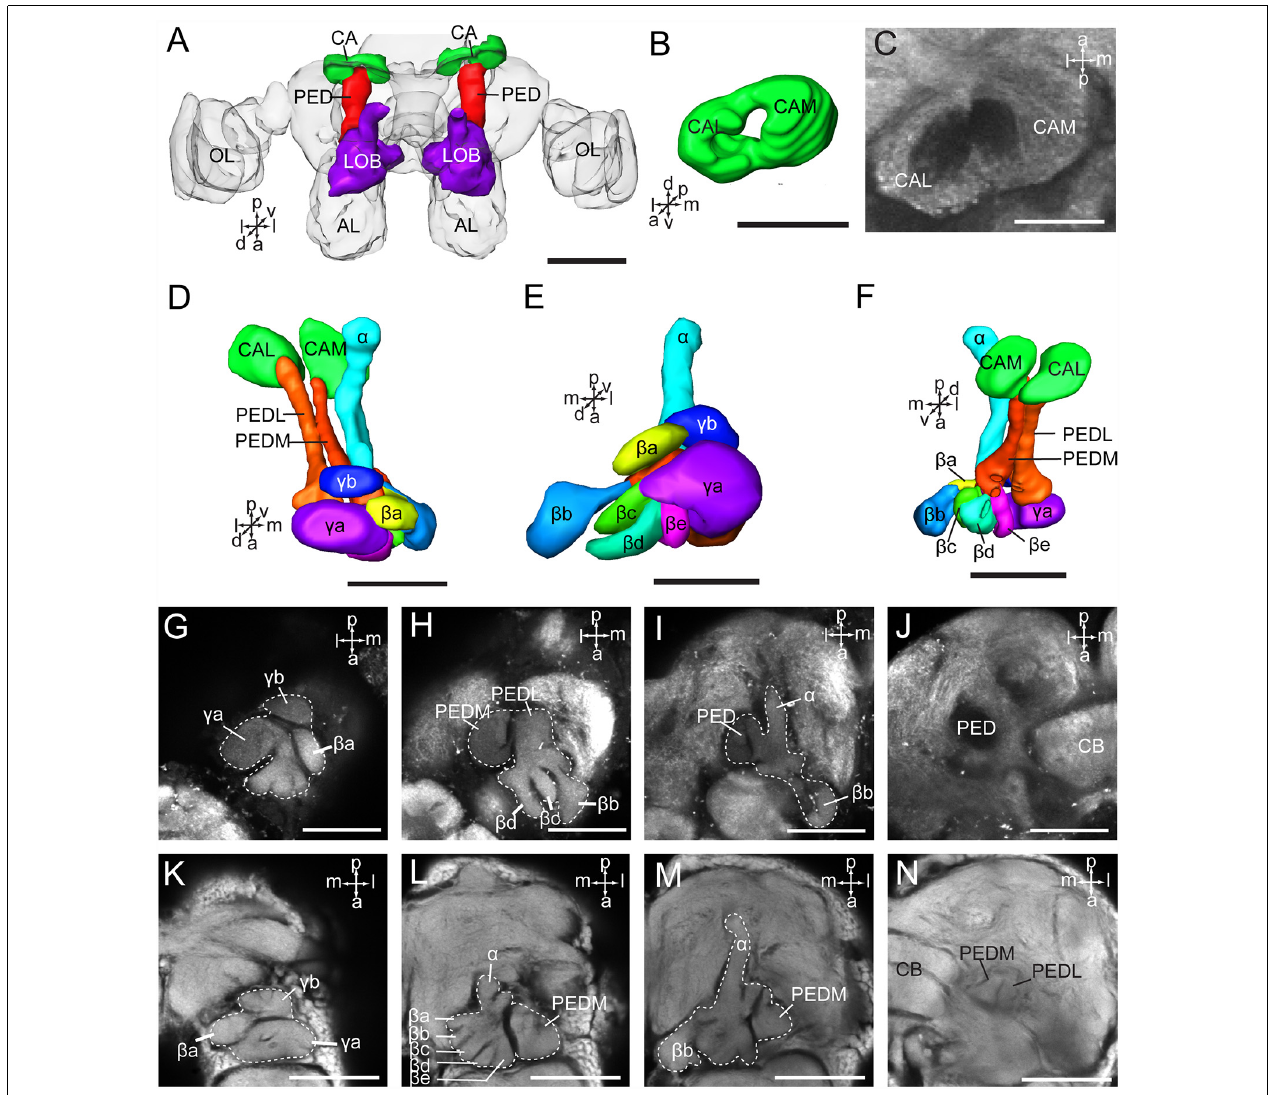
FIGURE 5 | Three-dimensional reconstructions and confocal images of Apolygus lucorum mushroom body. (A) Three-dimensional reconstructions of mushroom body in dorsal view. (B) Three-dimensional reconstruction of calyx in anterior view. (C) A confocal image showing the calyx. (D) Three-dimensional reconstructions of mushroom body in dorsal view. (E) Frontal view. (F) ventral view. (G–J) Confocal images at different depths showing mushroom body lobes of one preparation. (K–N) Confocal images at different depths showing mushroom body lobes of the other preparation. AL, antennal lobe; CA, calyx; CAL, lateral calyx; CAM, medial calyx; CB, central body; PED, pedunculus; PEDL, lateral pedunculus; PEDM, medial pedunculus; α , α lobe; β , β lobe; β a– β e, a–e five β lobelets; γ , γ lobe; γ a and γ b, a and b two γ lobelets. Scale bars: 100 µ m in (A) , 50 µ m in (B–N)